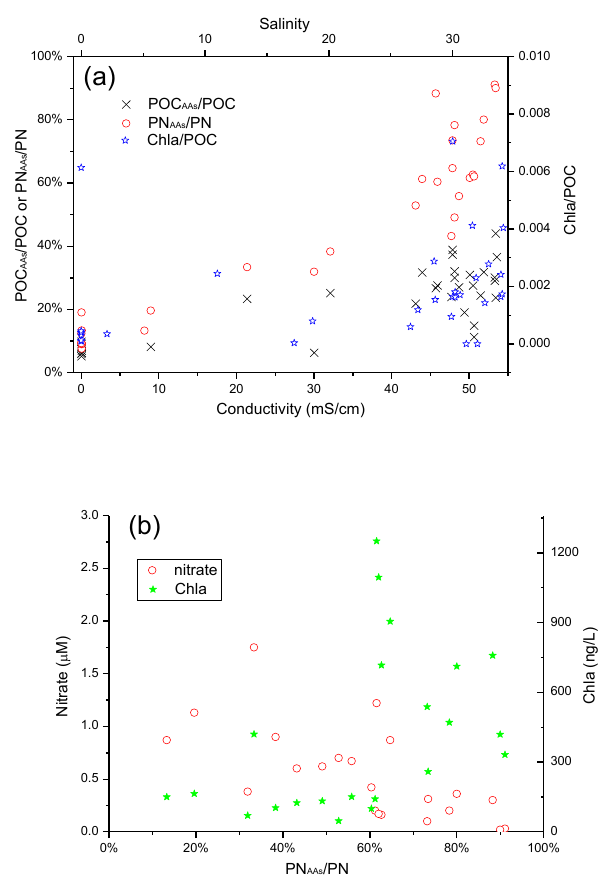
Figure 4. THPAA contribution to carbon and nitrogen: (a) along with salinity in the surface waters from glacier meltwater to the Kongsfjorden; (b) its relations with nitrate and Chl a for fjord sam- ples only (i.e., S>